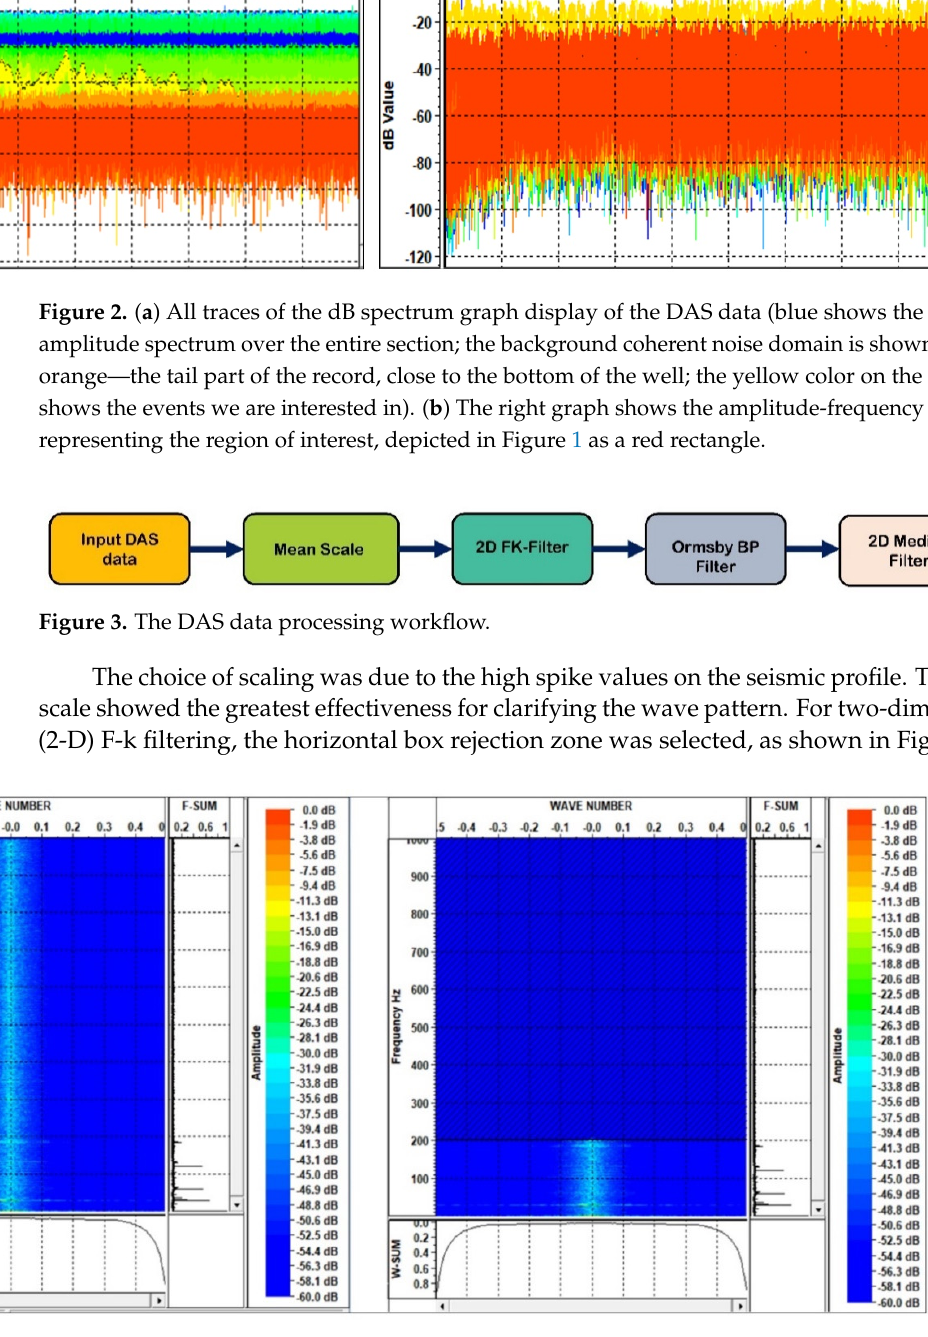
Figure 4. The original F-k area on the left. The right picture shows the horizontal box rejection